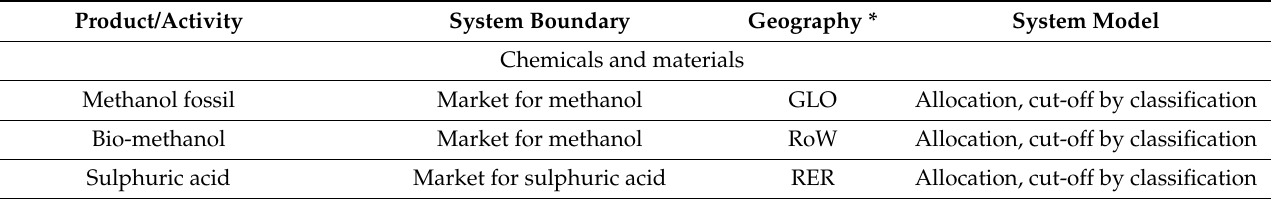
Table A1. Background processes for the LCA